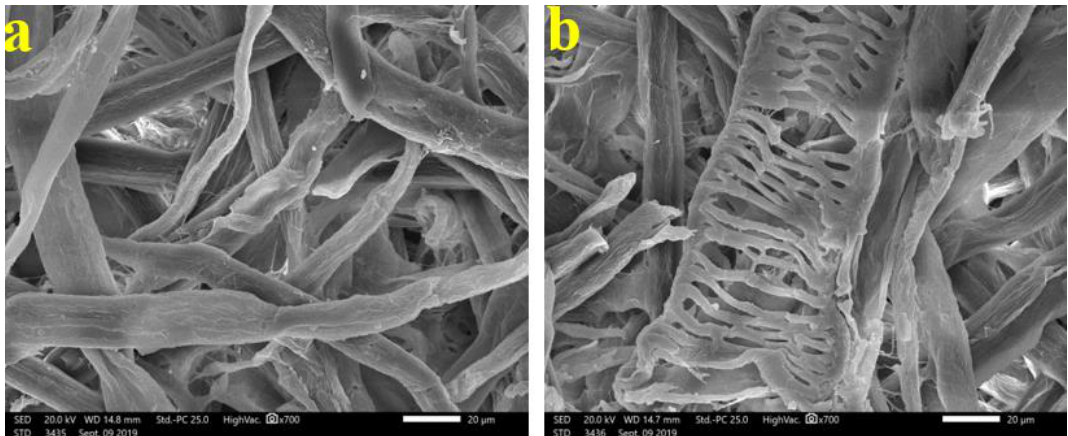
Figure 9. SEM images shows inhibition of fungal growth on M. sinclairii WB pulp paper produced with the addition of HeOEs and inoculated with A. terreus : ( a ) with M. azedarach HeOE at 3%; ( b ) with M. azedarach HeOE at 5%; ( c ) with S. alba HeOE at 3%; ( d ) with S. alba HeOE at 5%; ( e ) with M. grandiflora HeOE at 3%; ( f ) with M. grandiflora HeOE at 5%.